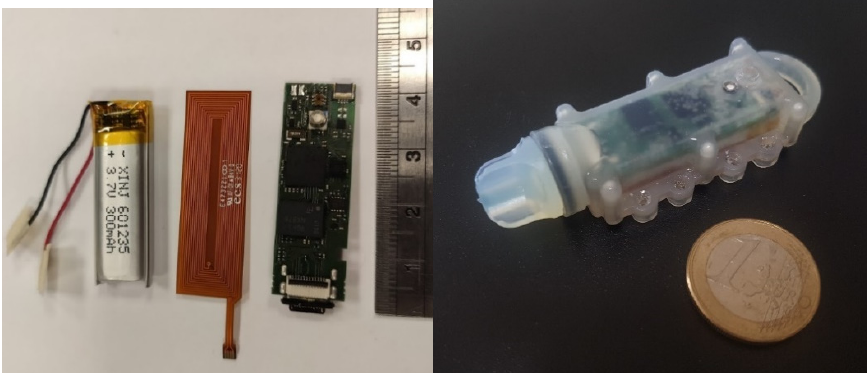
Figure 8. Final embedded system for seaweed monitoring before and after encapsulation for de- ployment.